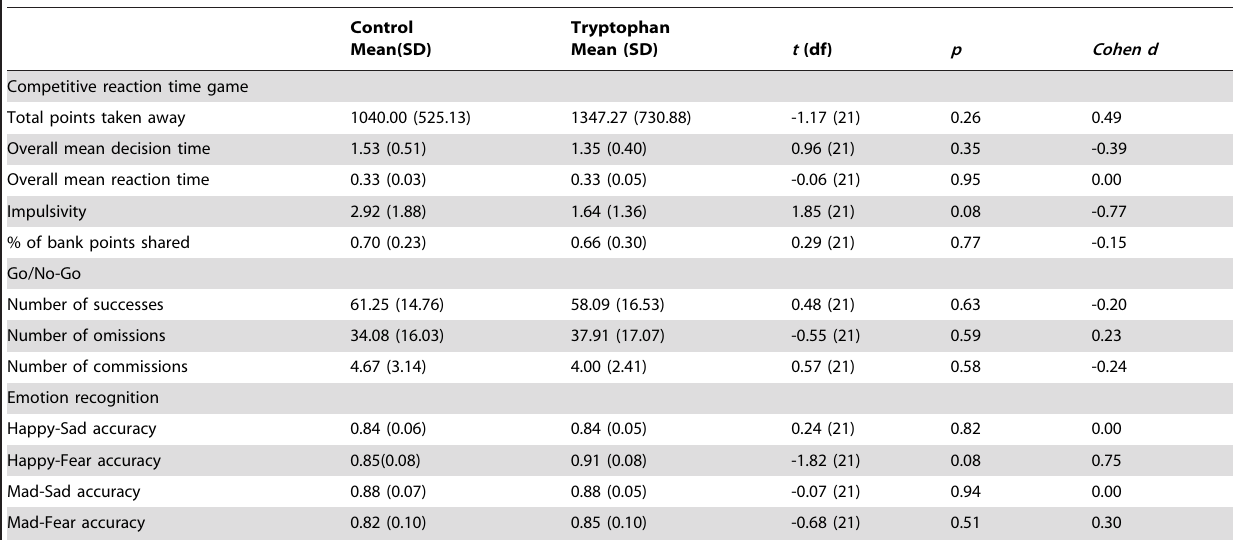
Table 1. Group differences on experimental